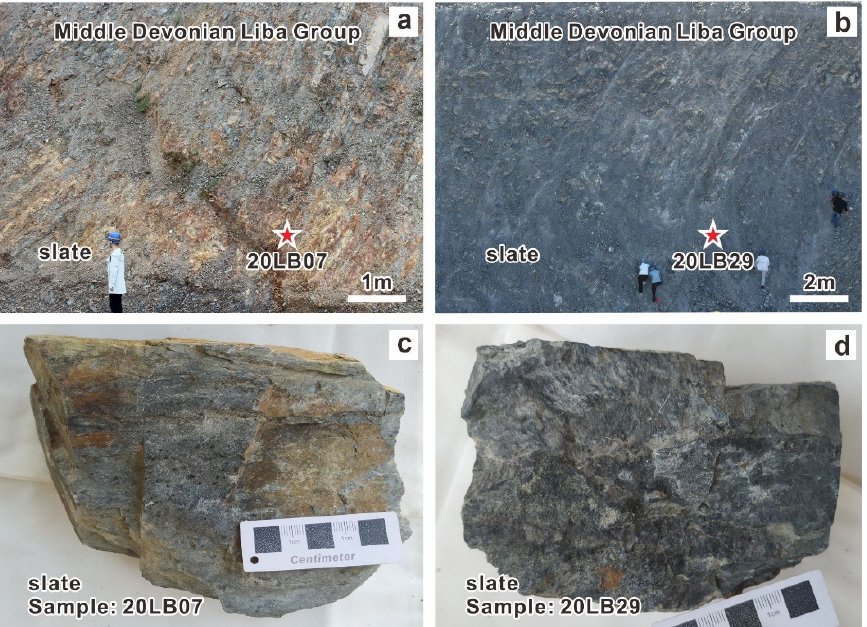
Figure 3. ( a , b ) Field photographs showing the slaty structure of the Middle Devonian Liba Group. ( c , d ) Hand specimens of the Middle Devonian Liba Group.